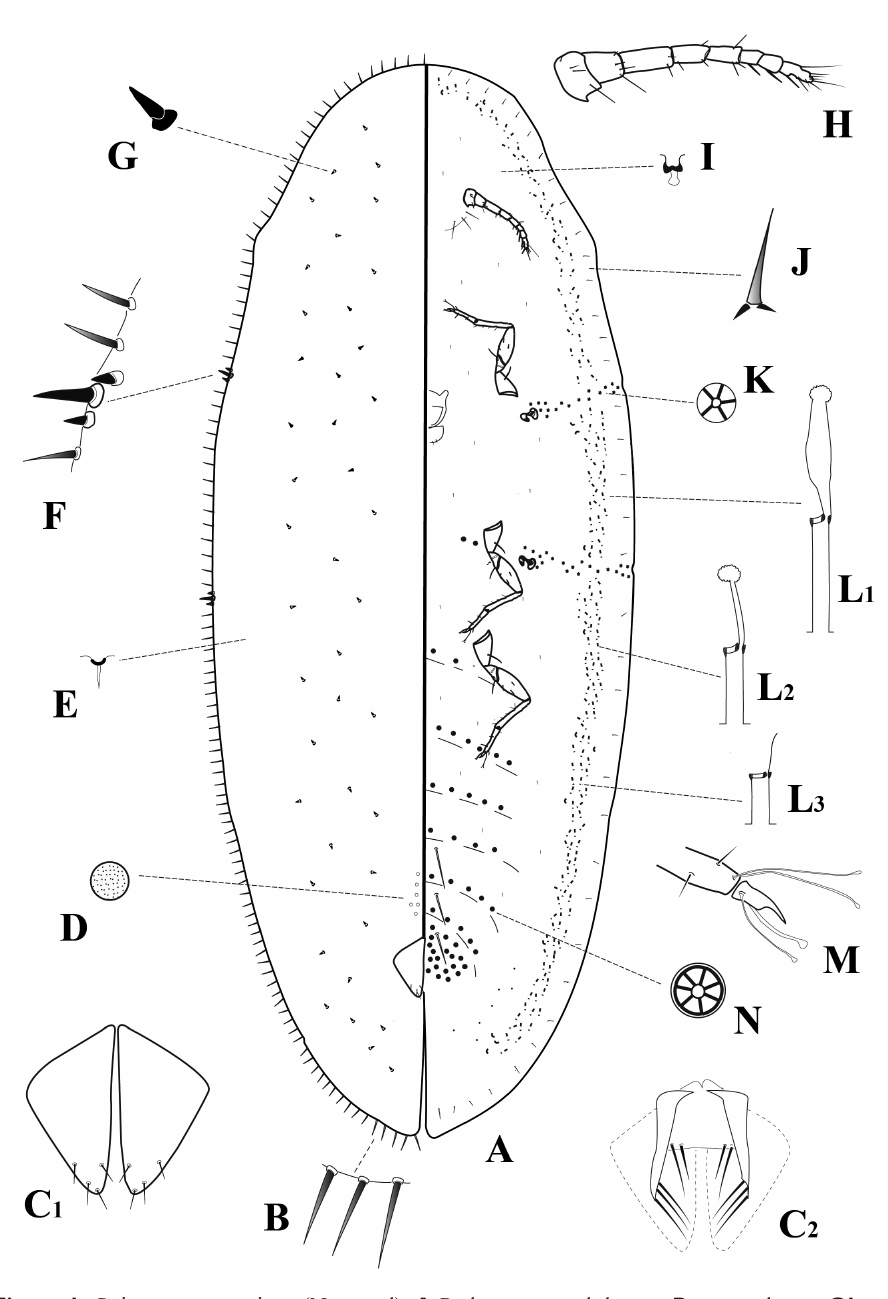
Figure 1. Pulvinaria tenuivalvata (Newstead). A Body, venter and dorsum B marginal setae C1 anal plates, dorsal view C2 ano-genital fold D dorsal discoidal pore E dorsal filamentous pore F spiracular setae G dorsal seta H antenna I ventral microduct J ventral submarginal seta K spiracular disc-pore L ventral tubular ducts of three types: L1, type I, L2, type II, L3, type III M claw digitules unequal N multilocular